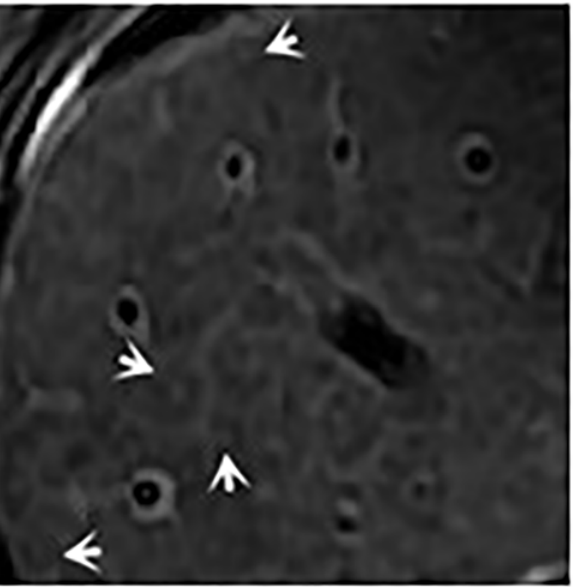
Fig 4. male, 61 years, axial T2-weighted image shows periportal halo signs as hypointense areas around the portal veins ( arrows ).